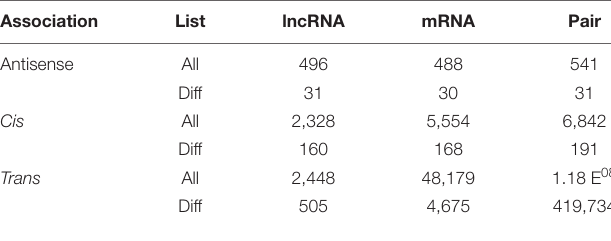
TABLE 1 | Association analysis between lncRNA and